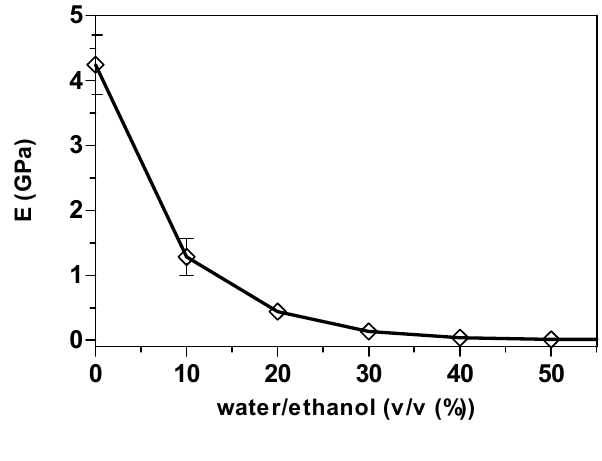
Figure 2. The variation of Young’s modulus ( E ) with water/ethanol mixtures for CHT